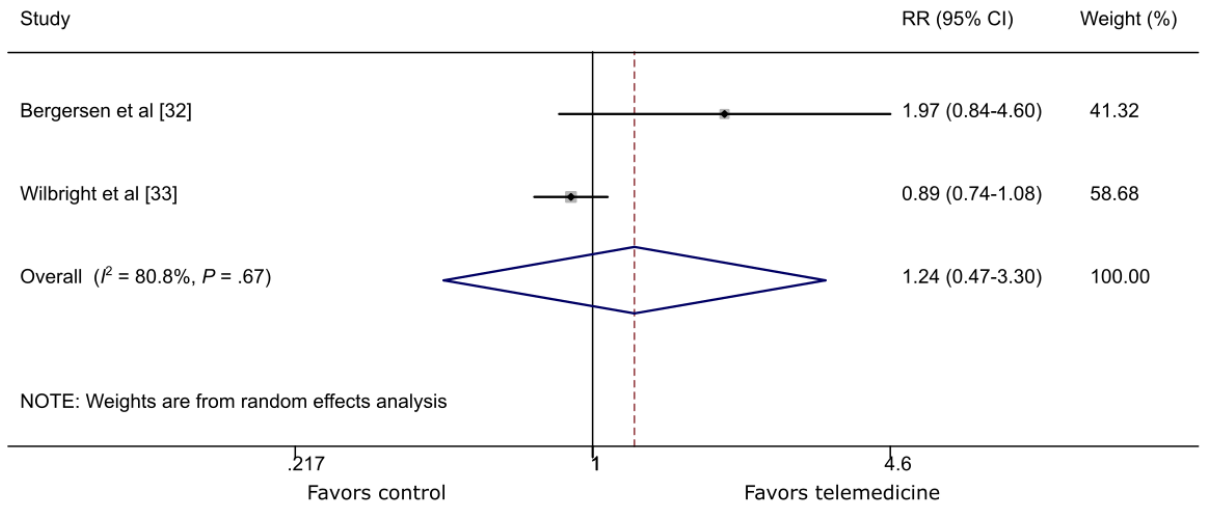
Figure 3. The effect of telemedicine on wound healing around 3 months. RR: risk